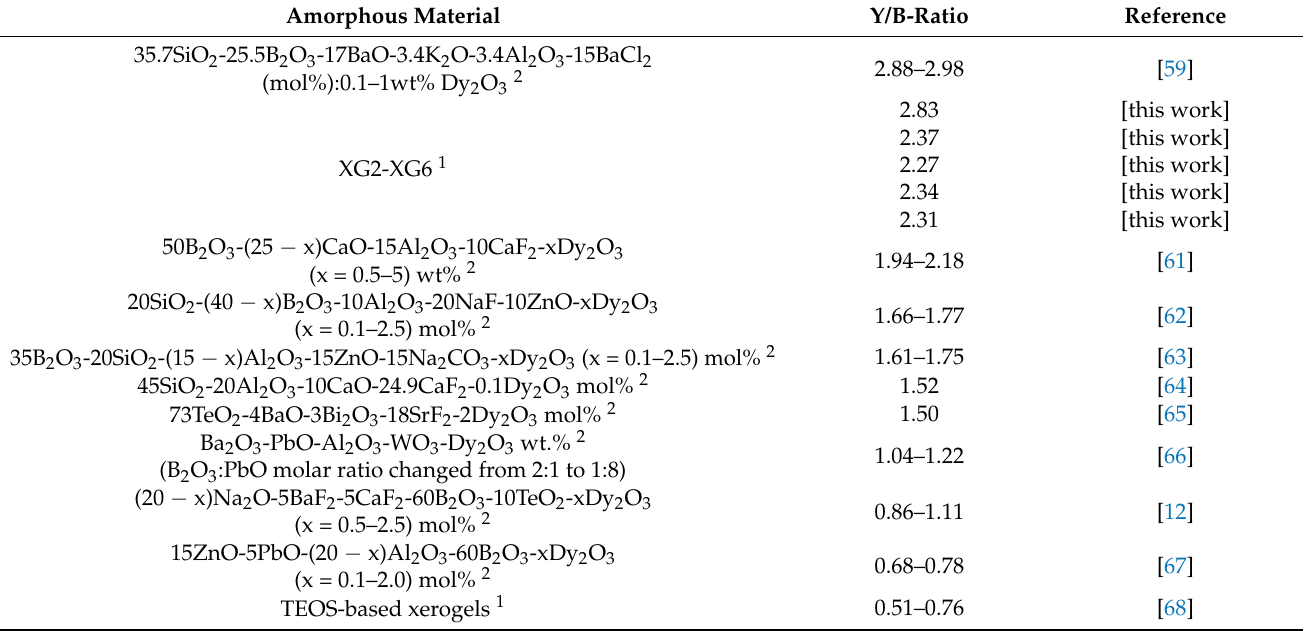
Table 3. Y/B-ratios for different types of amorphous optical materials doped with Dy 3+ ions. Amorphous